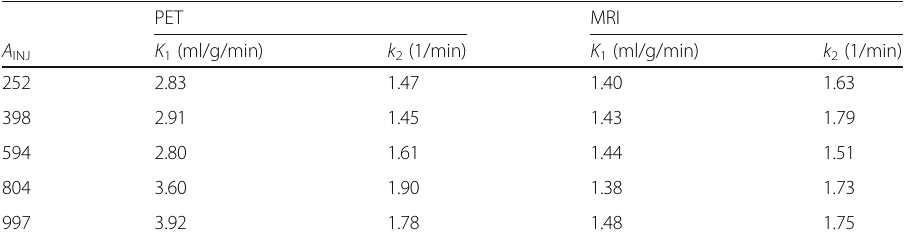
Table 1 Resulting perfusion parameters from phantom experiments with increasing A INJ showing an overestimation of K 1 resulting from increased areas underneath C M (PET) and decreasing areas of C A (PET) . MRI perfusion estimations show consistent values at all activities PET MRI A K INJ 1